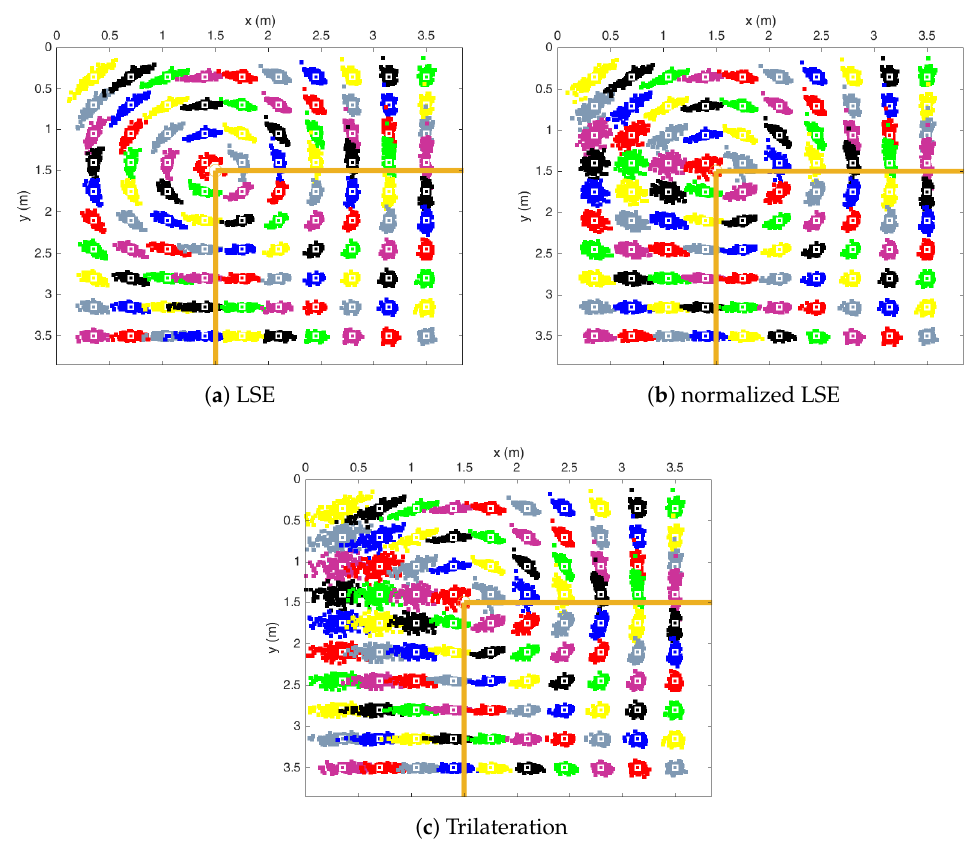
Figure 5. Scatter plot of 250 location estimations for each of 100 locations (indicated by white-edged dots) in top left part of the 7 m by 7 m square of Figure 3, for a LED height of 2.5 m and a σ tilt = 2°. The LED square is indicated with an orange